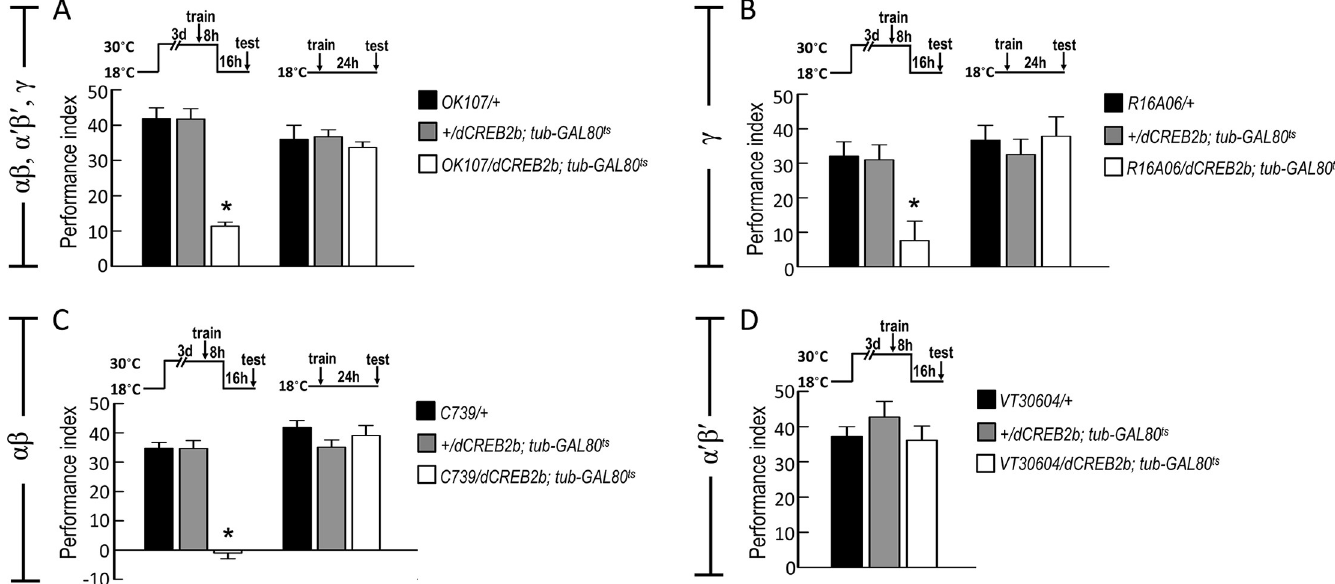
Fig 2. Adult stage-specific expression of dCREB2b in αβ and γ neurons disrupts wLTM. (A) Inducible expression of dCREB2b in MB neurons using OK107-GAL4 impaired the 24-hour water-reward memory. Adult flies were raised at 18˚C and then transferred to 30˚C for three days before training to remove tub-GAL80ts inhibition of GAL4 activity. Each value represents mean ± SEM (N = 7~9). � , p < 0.05; one-way ANOVA followed by Tukey’s test. (B) Inducible expression of dCREB2b in γ neurons using R16A06-GAL4 impaired the 24-hour water-reward memory. Each value represents mean ± SEM (N = 6~11). � , p < 0.05; one-way ANOVA followed by Tukey’s test. (C) Inducible expression of dCREB2b in αβ neurons using C739-GAL4 impaired the 24-hour water-reward memory. Each value represents mean ± SEM (N = 8). � , p < 0.05; one-way ANOVA followed by Tukey’s test. (D) Inducible expression of dCREB2b in α 0 β 0 neurons using VT30604-GAL4 did not affect the